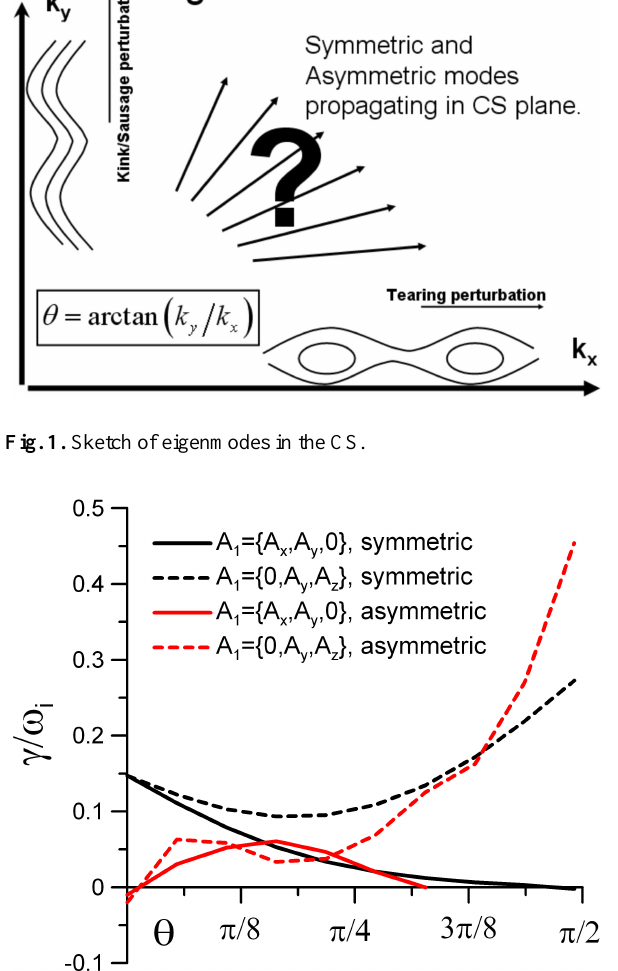
Fig. 2. Growth rate as a function of angle θ for two polariza- tions. The parameters have the following values: τ = 3, L CS = 0 . 8 ρ i , kL CS = 0 . 3, b n = 0 . 1.